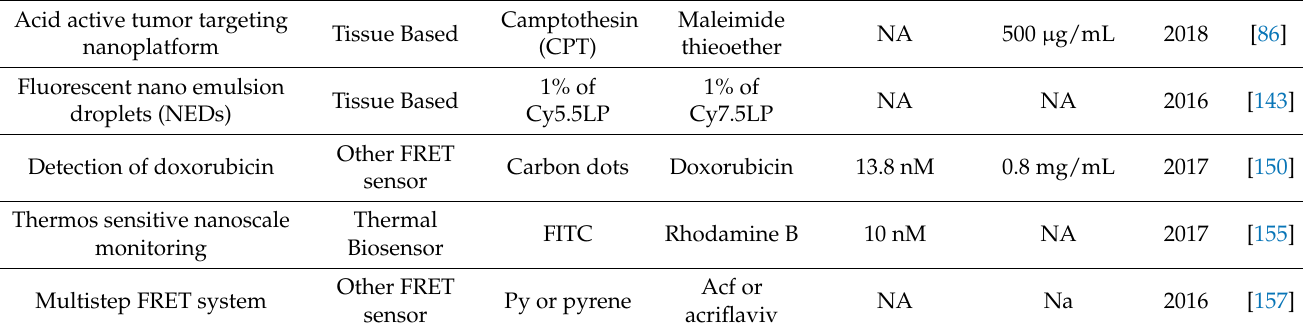
Table 4. Tissue-based FRET biosensor and various other biosensors showing donor, acceptor, LOD, CR, and year-wise advancement in